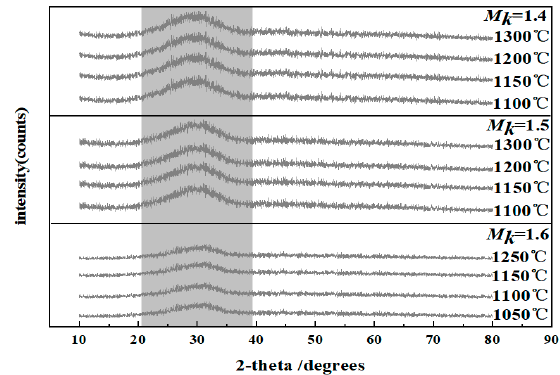
Figure 6. Effect of the final temperature during furnace cooling and the M k values on the phase composition of the modified blast furnace slag.